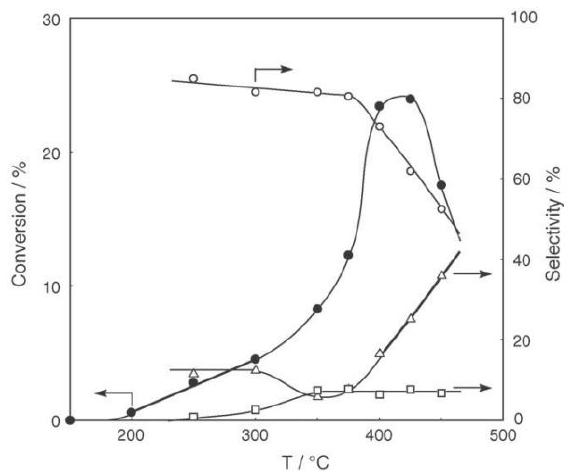
Figure 23. Effect of temperature on the reaction of benzaldehyde with acetone over [(Ta Cl )Cl (H O) ]·4H O/SiO in a helium stream. Following activation of the supported 6 12 2 2 4 2 2 cluster (100 mg, 2.9 μmol) in a helium stream (300 mL/h) for 1 h, reaction was started by introduction of a mixture of benzaldehyde (58 μL/h, 0.57 mmol/h) and acetone (42 μL/h, 0.57 mmol/h) to the stream without changing the temperature. Conversion and selectivities are based on aromatic compounds. Conversion of benzaldehyde (●); selectivity for aldol condensation to E -4-phenyl-3-buten-2-one (○); selectivity for hydrogenolysis to benzene, toluene, and styrene (∆); and selectivity for indenes (□); at 3 h after the reaction